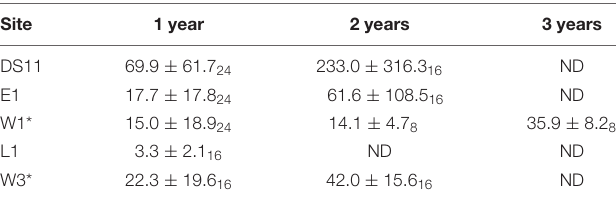
Frontiers in Marine Science |